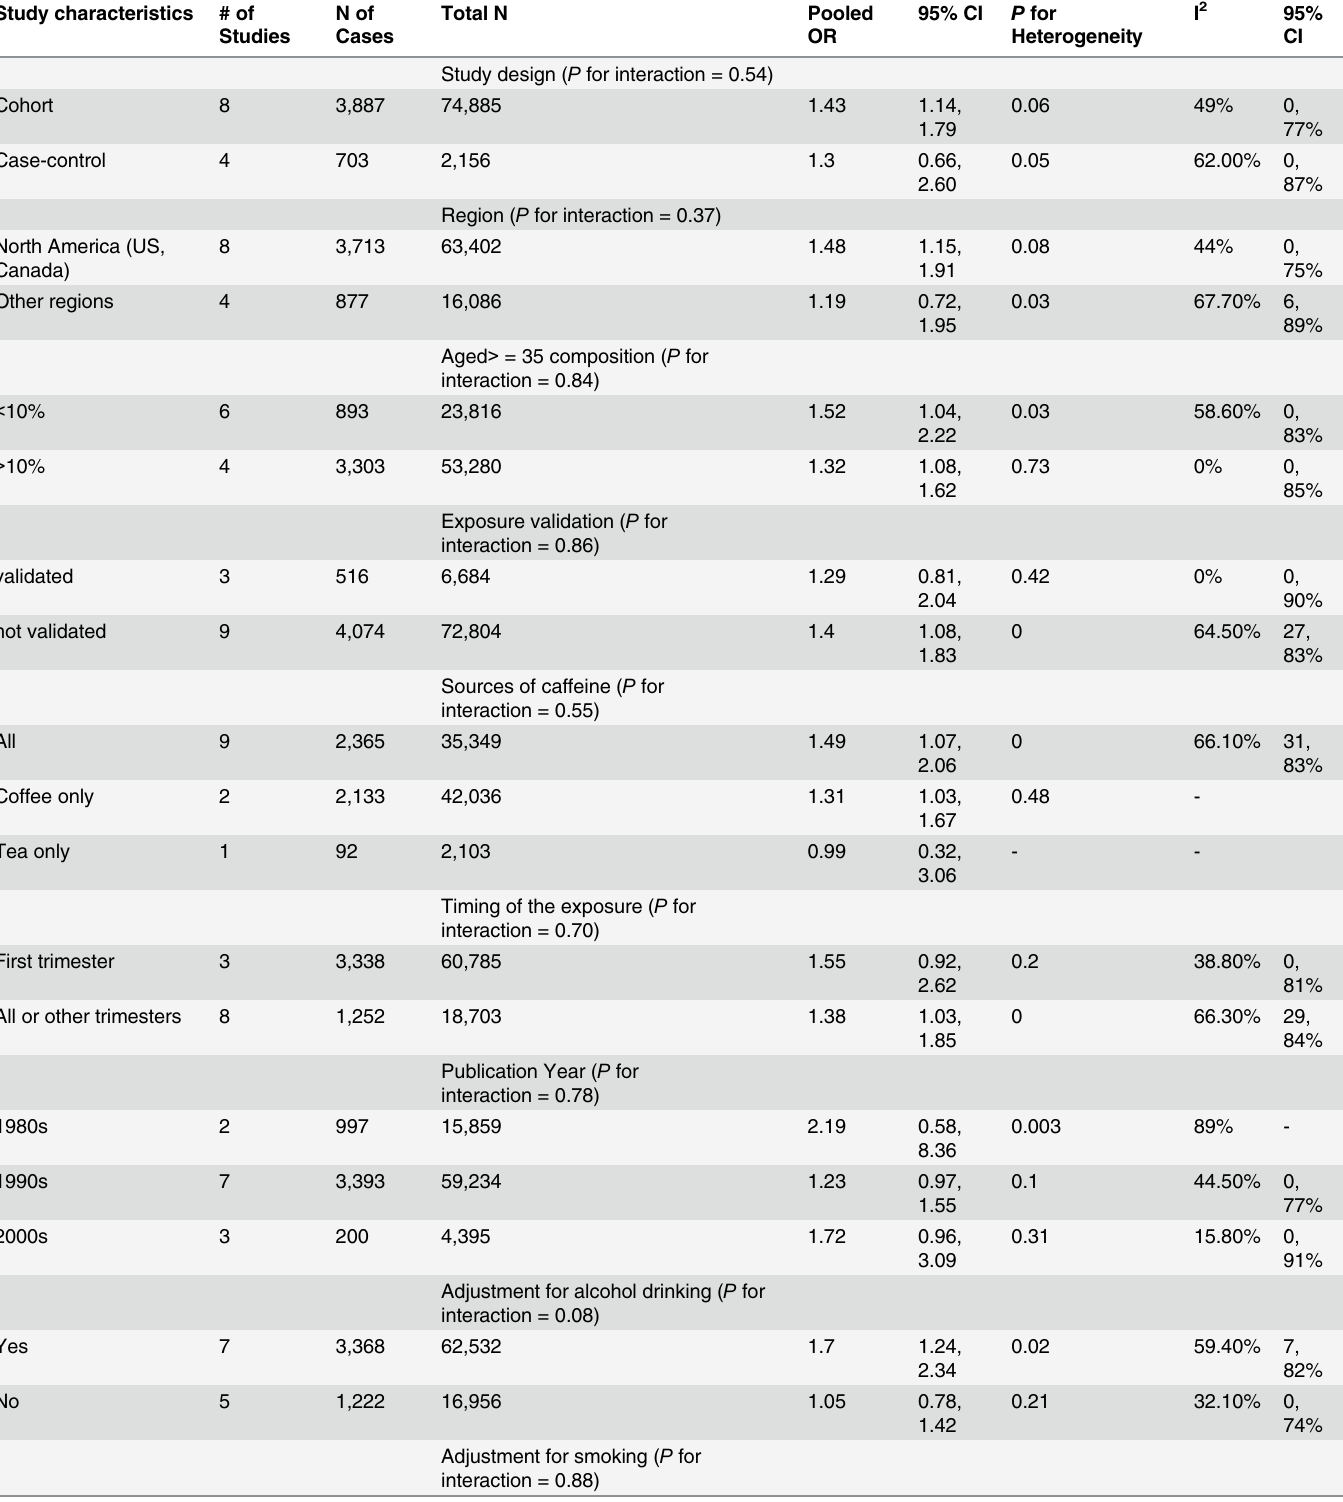
Table 3. Subgroup meta-analyses of maternal caffeine intake during pregnancy and